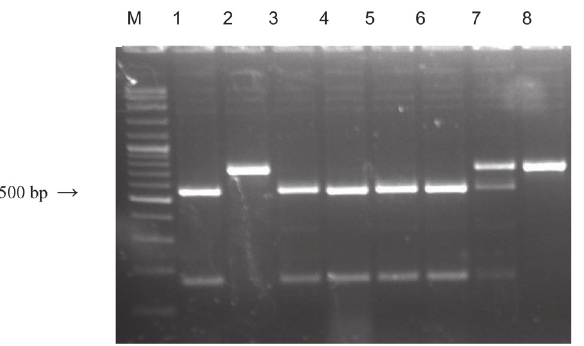
Figure 1. Digestion of REX-1 PCR product with Taq I (M, 1 kb molecular weight marker (Vivantis): 1, homozygous control plant; 2, susceptible control plant; 3, Beaufort; 4, Vigomax; 5, PI 126443; 6, PI270435; 7, astona RN F1; 8, Simita